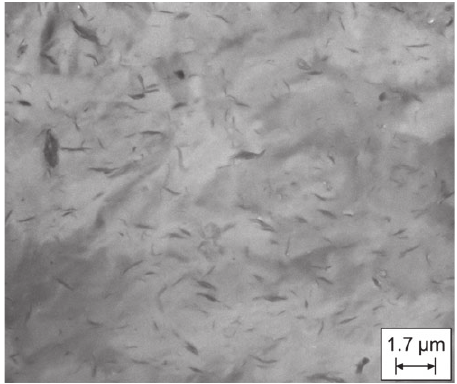
Figure 11 Dispersion of NC achieved with a screw configuration introducing a high level of shear